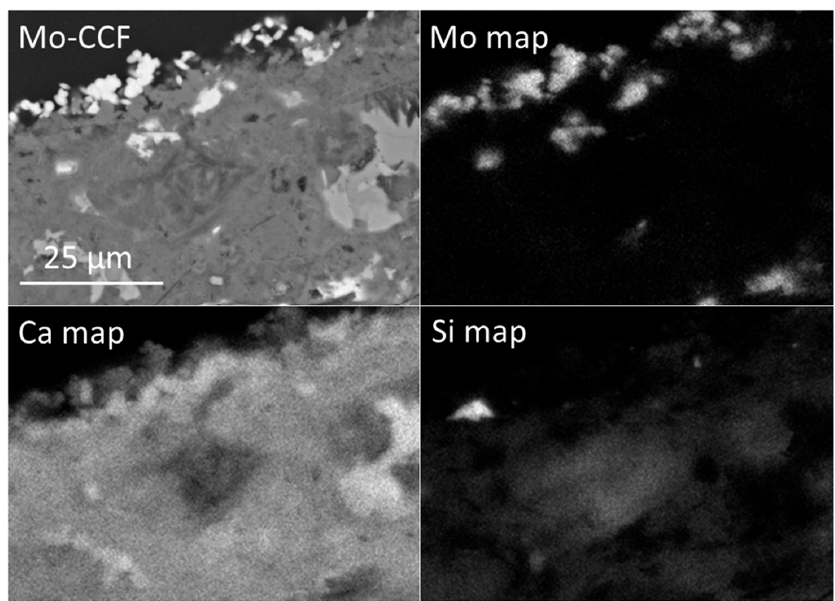
Figure 9. Back-scattered electron micrograph of cross section of molybdenum-laden CCF particle and corresponding EDX maps for molybdenum, calcium and silicon. All images are of the same sample area.